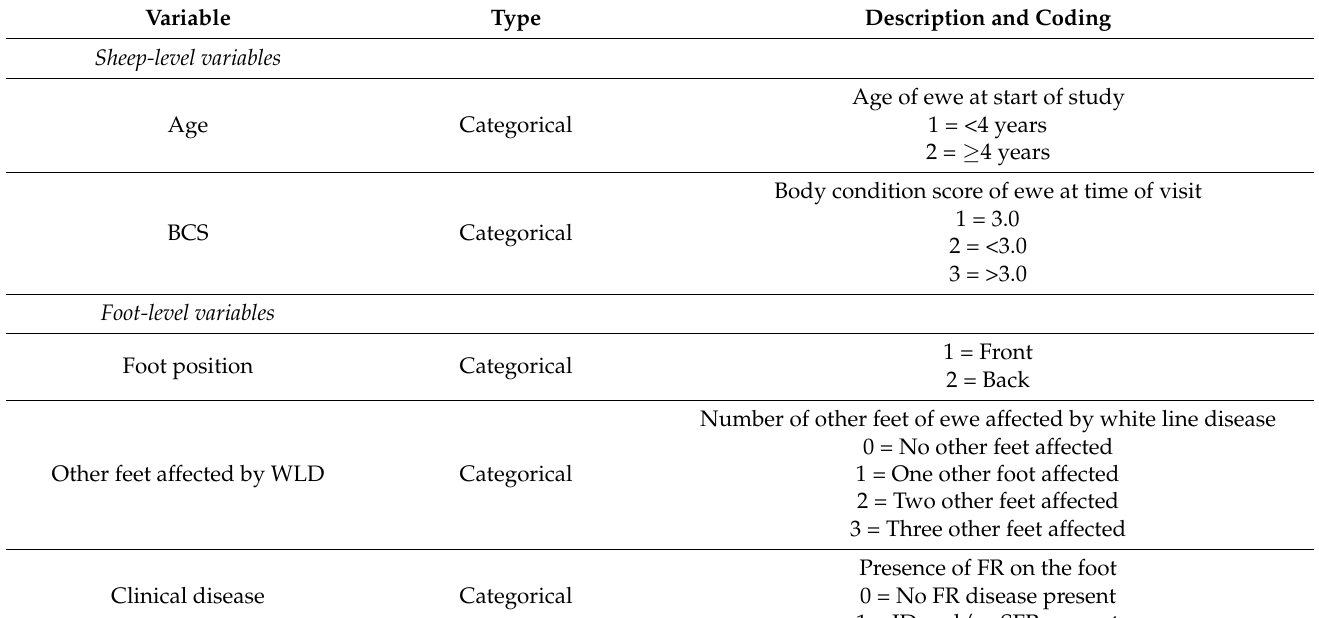
Table 3. Description of variables considered when investigating associations with presence of white line disease at foot-level and number of feet affected at